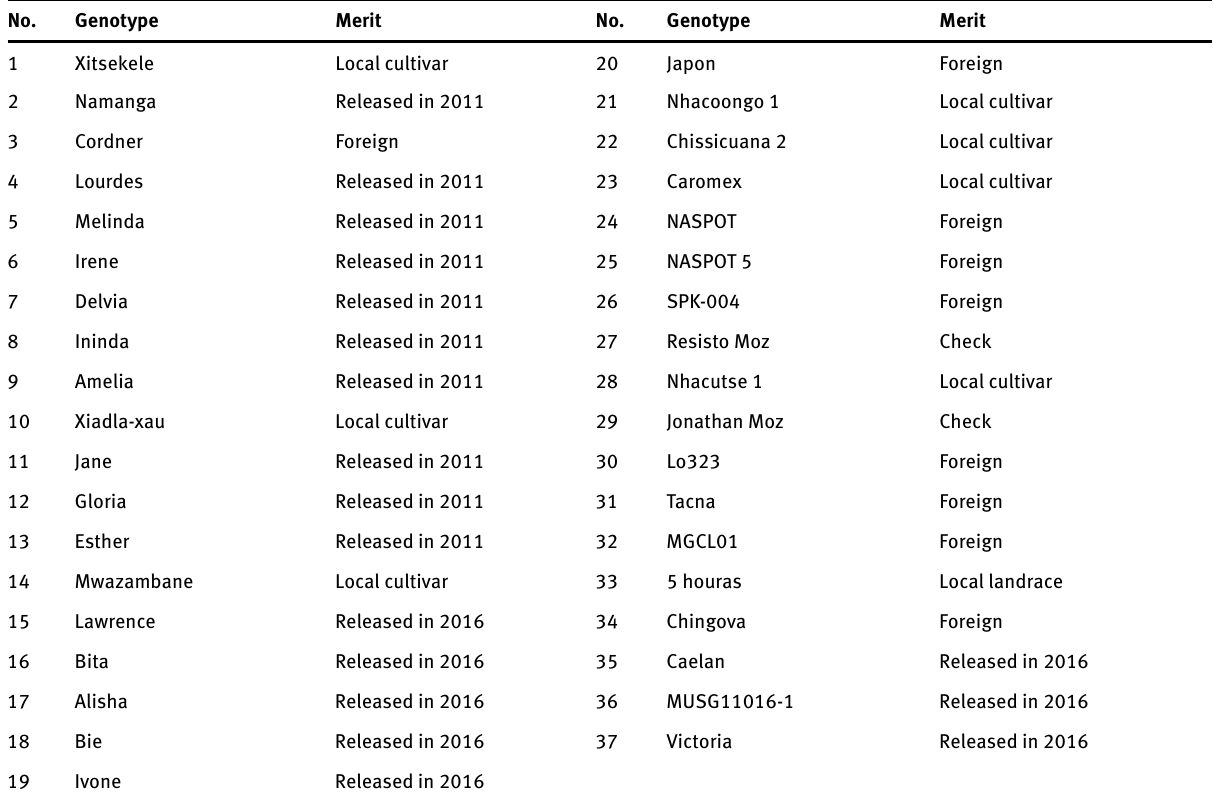
Table 1: List of germplasm evaluated for the heritability of vine survival trait